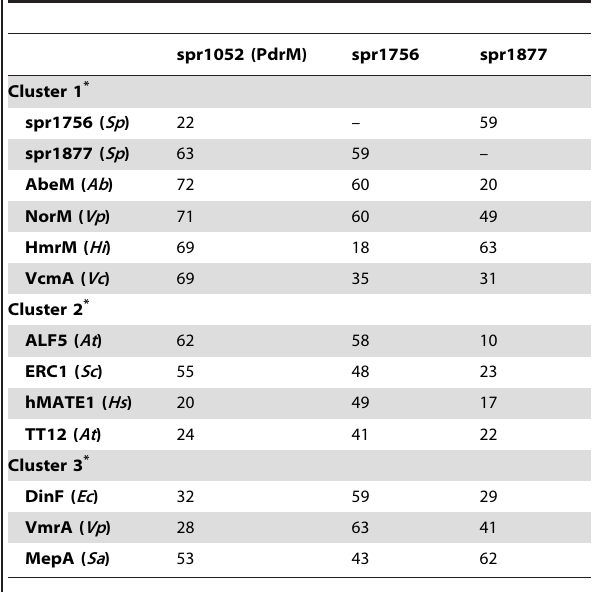
Table 1. Similarity of putative MATE transporters in